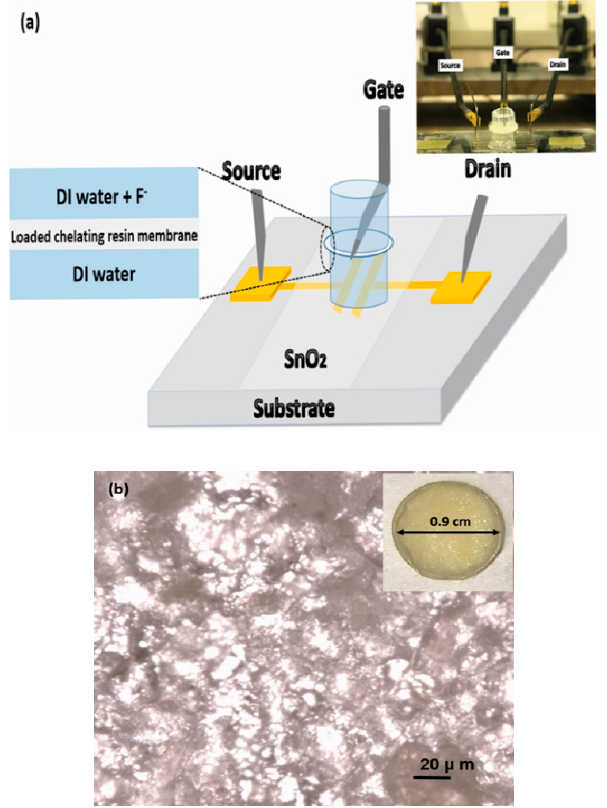
Figure 2. Measurement setup and membrane morphology. ( a ) Water-gated thin-film transistors (WGTFT) setup for fluoride sensing. Inset to 2a: photograph of the chelating resin-sensitised SnO 2 WGTFT sensor platform. ( b ) Micrograph of La-loaded chelating resin distributed in poly(vinyl chloride) (PVC) phase transfer membrane, in which the darker section of the image is for resin while lighter is for PVC. Inset to 2b: Photograph illustrates the diameter of La- chelating resin-loaded PVC phase transfer membrane. Resin loading in the membrane was 5.6